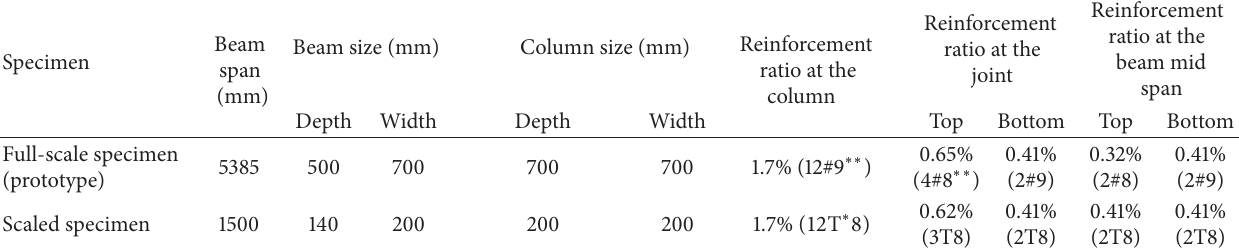
Table 1: Geometric properties of prototype frames and specimens.